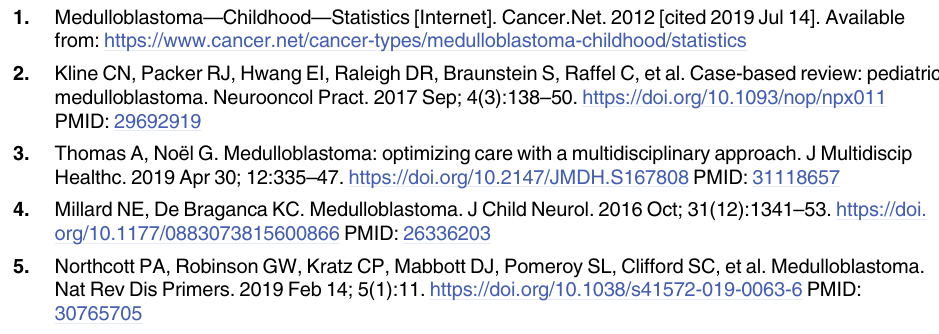
S1 Table. 1,399 genes associated with specific medulloblastoma subtypes.